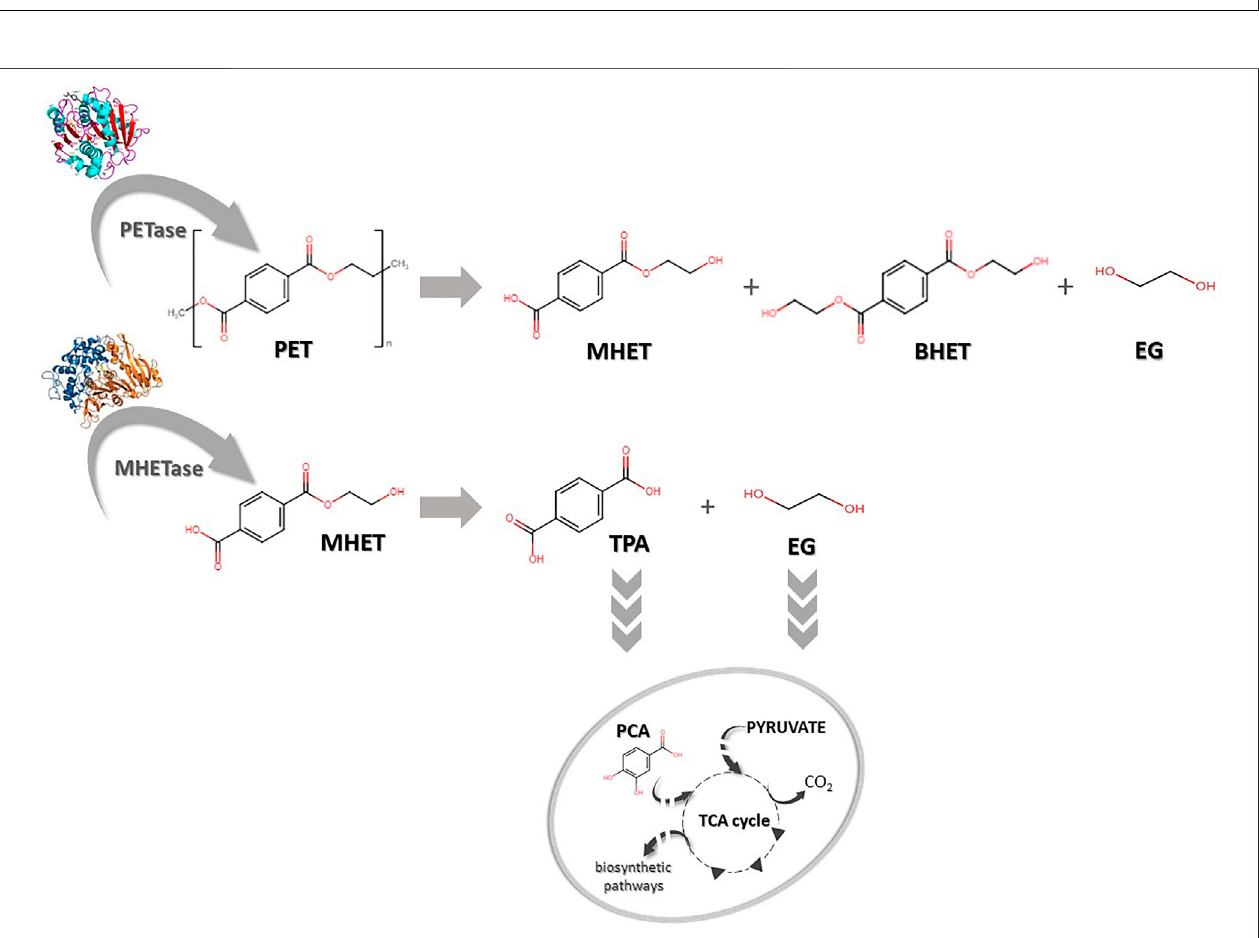
FIGURE 2 | Biodegradation of polyethylene terephthalate (PET). PET can be degraded into mono-(2-hydroxyethyl) terephthalate (MHET), bis-(2-hydroxyethyl) terephthalate (BHET) and ethylene glycol (EG) by PETase. MHET can later be hydrolysed to terephthalic acid (TPA) and EG by MHETase. TPA and EG can be further transported into the cell and converted to protocatechuic acid (PCA) and subsequently integrated into cellular metabolisms via the tricarboxylic acid cycle (TCA).